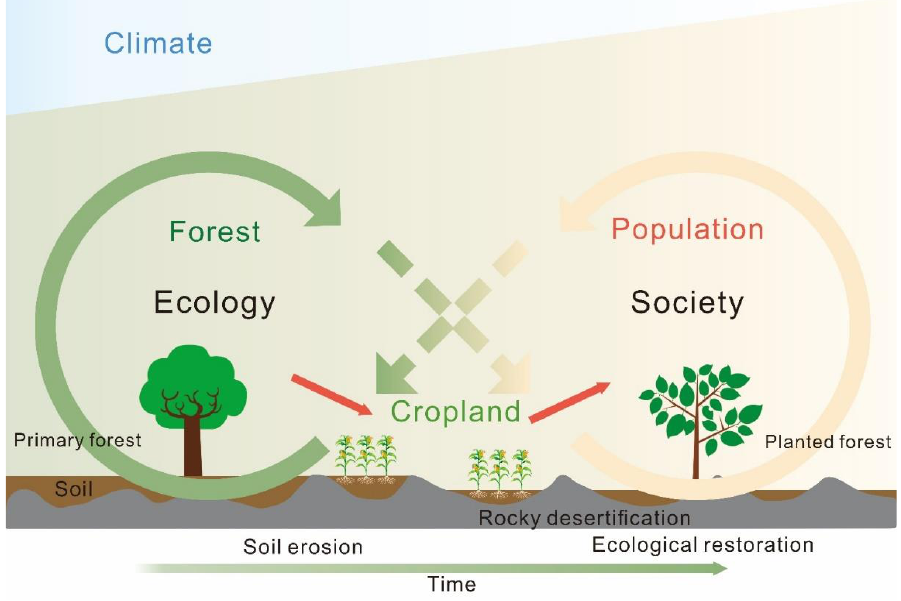
Figure 8. Conceptual evolution of a karst SES with increasing population pressure and human im-